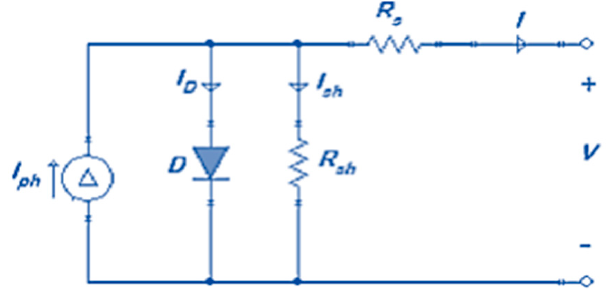
Figure 1. Equivalent circuit of the single diode model (SDM).